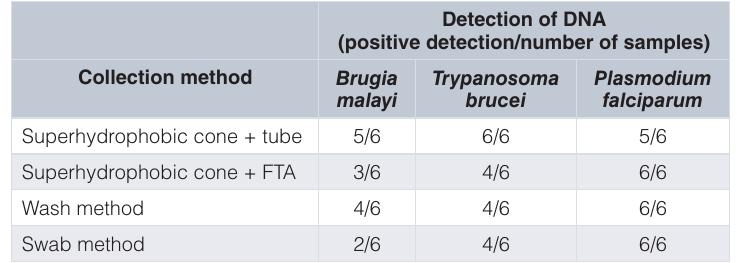
Table 1. Detection of parasite DNA for each of the four different excreta/ feces collection methods. Detection of DNA (positive detection/number of samples) Collection